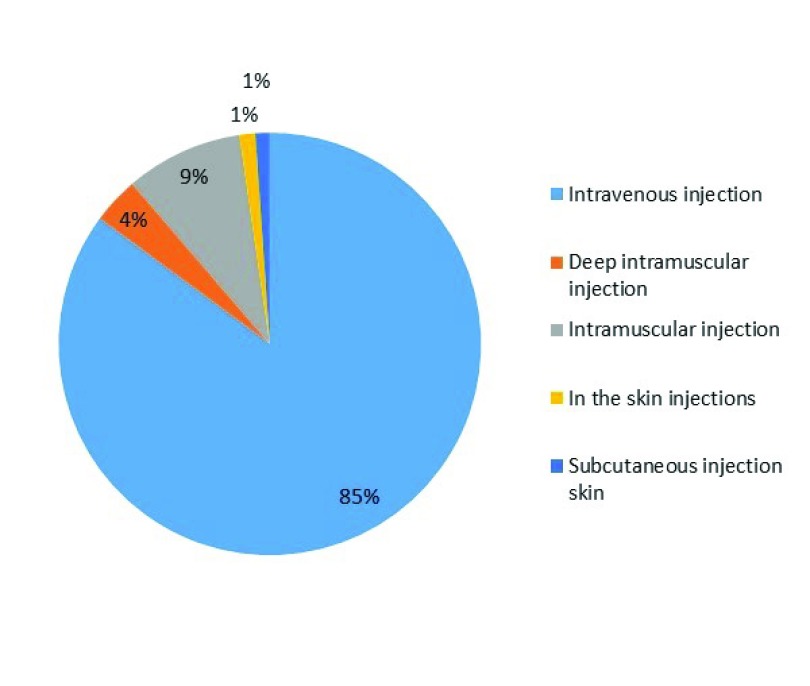
Number of injections by parenteral administration.